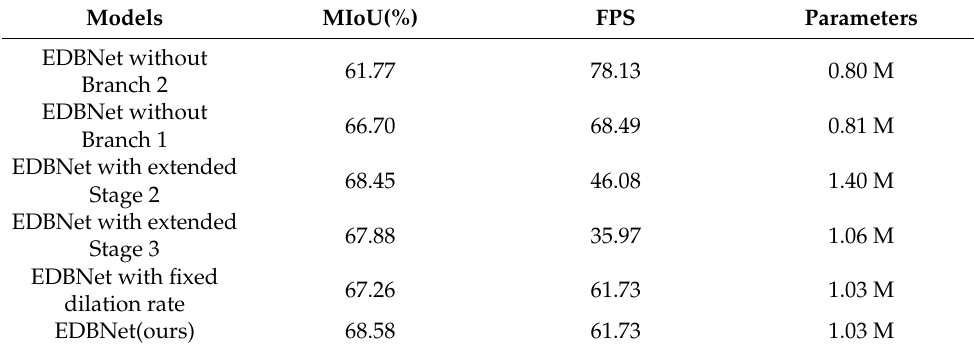
Table 1. Ablation Experiments on CamVid